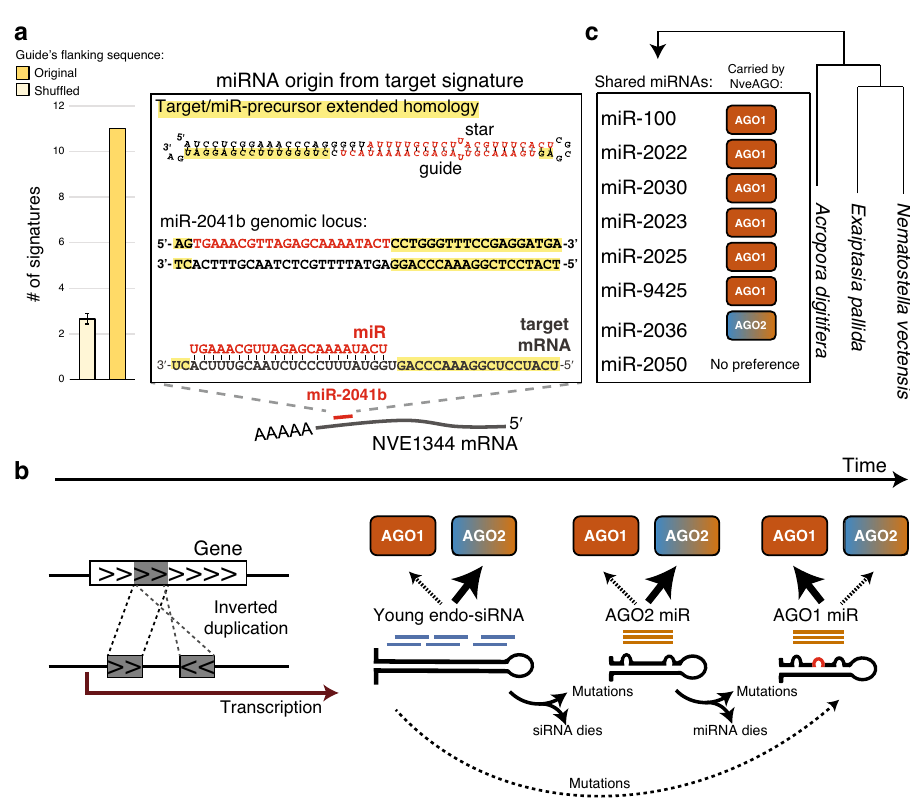
Fig. 6 Model for origin and evolution of miRNA-precursors in Hexacorallia . a Extended homology between miRNA precursors and their targets. The number of precursors with extended homology was calculated for the list of 138 miRNAs, and an average for 50 lists with shuf fl ed sequences of the Guide ’ s fl anking regions (Data are presented as mean values + / − SE for the shuf fl ed sequences). A signature is exempli fi ed for miR-2041b and its predicted target NVE1344 (right panel). b The model suggests endo-siRNA origin (that load into hexacorallian AGO2) from inverted duplications of coding genes. Next, precursors acquire mutations that result in processing by the miRNA biogenesis machinery, and such precursors are still loaded into hexacorallian AGO2. Additional mutations such as a central mismatch in duplexes might result in the miRNA being directed to hexacorallian AGO1. c miRNAs shared by sea anemones and reef-building corals and their AGO preference in Nematostella as discovered in this